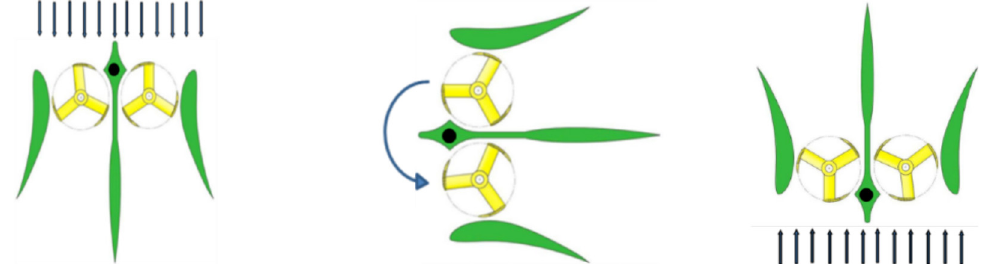
Fig. 6. Auto-orientation of the HPS facing the current, with a rotation of about 180 ° during the change of tide.